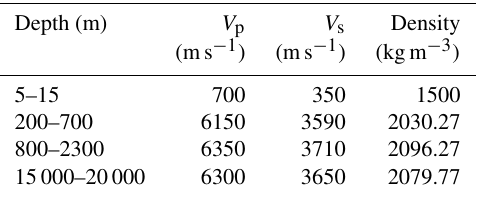
Table 3. Parameters of the starting velocity model for inversion of dispersion